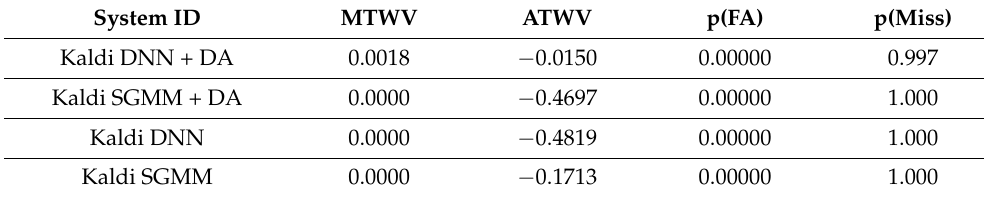
Table 8. System results of the STD task for MAVIR development data.